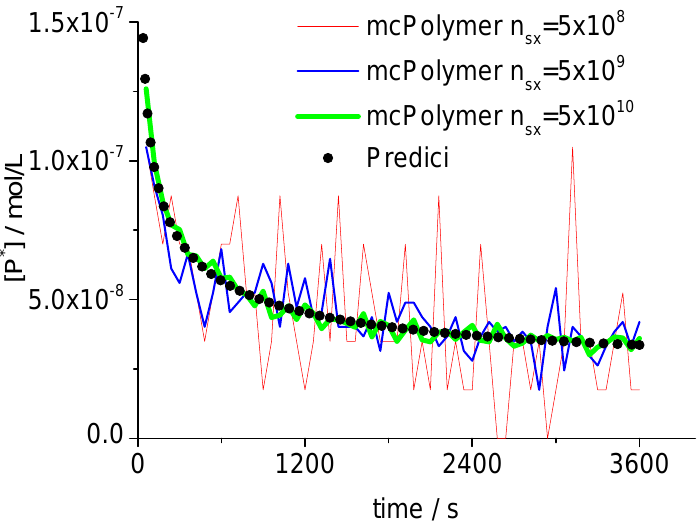
Figure 5. Concentration of propagating chains compared to PREDICI simulation